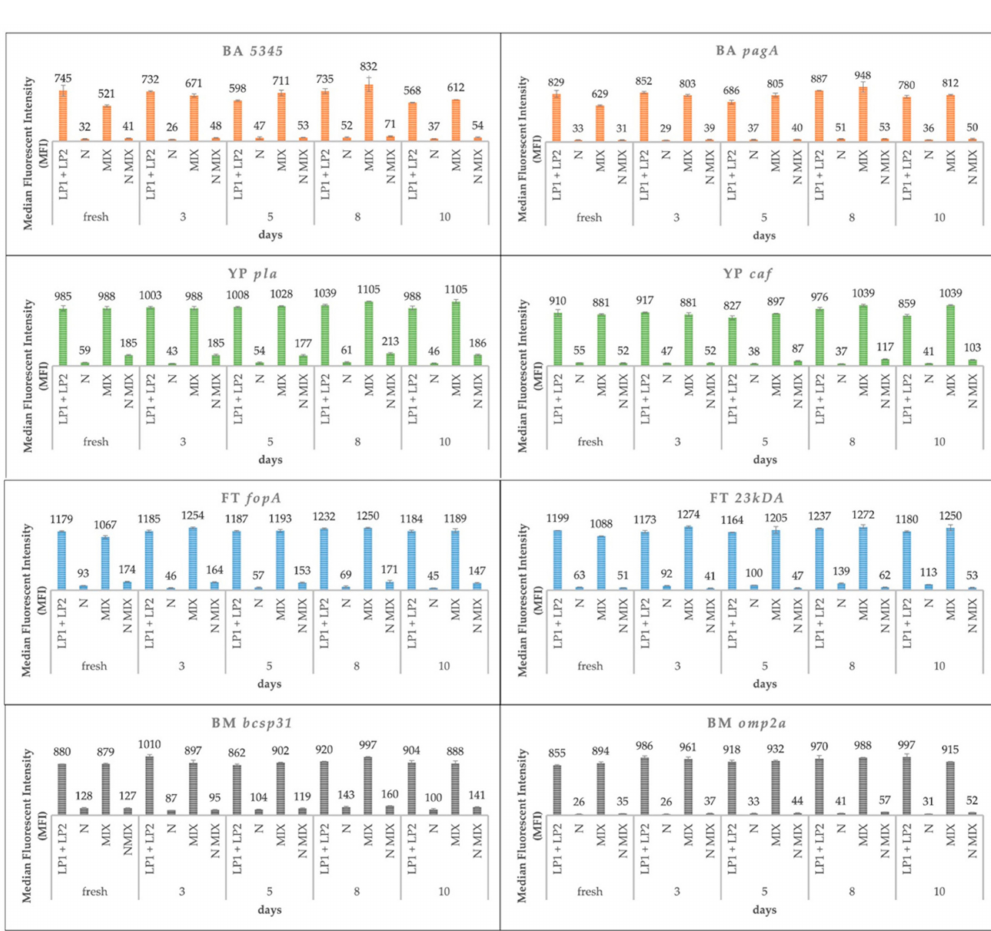
Figure 5. Long-term storage effect of ligation mix.—Experiment based on evaluating the stability of different types of ligation premix storage over time (MOLigo probes separately LP1 + LP2 or all MOLigo probes together—MIX). Better protocol performance was recorded when the two probes premix were stored separately. Abbreviations: LP = ligation premix; N = Negative control; MIX = mix of all probes in the ligation